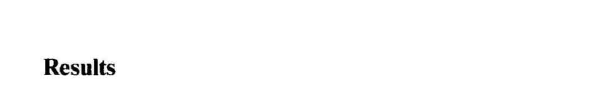
4/6 patients, whereas the other acute phase protein fibrinogen was normal in 4/6 cases. In 5/6 patients ESR was increased, WBC within normal range (Ta ble I). Neopterin was especially a helpful marker for the monitoring of treatment with tuberculostatic drugs. After a sufficient treatment of tuberculous bone infections neopterin levels decreased and re mained within normal range (Figure 1-3). In one patient (A.K., 87 years) with a spondylodiscitis